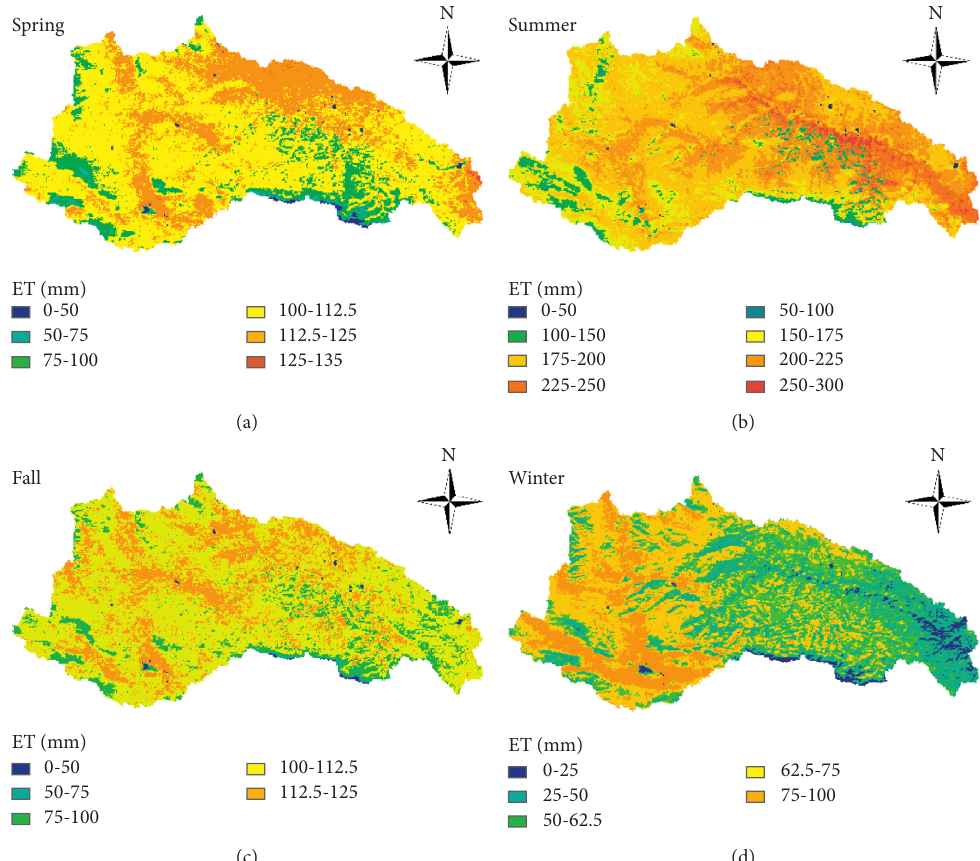
Figure 9: Spatial distributions of seasonal ET during 2001–2018 in the upper Taohe River